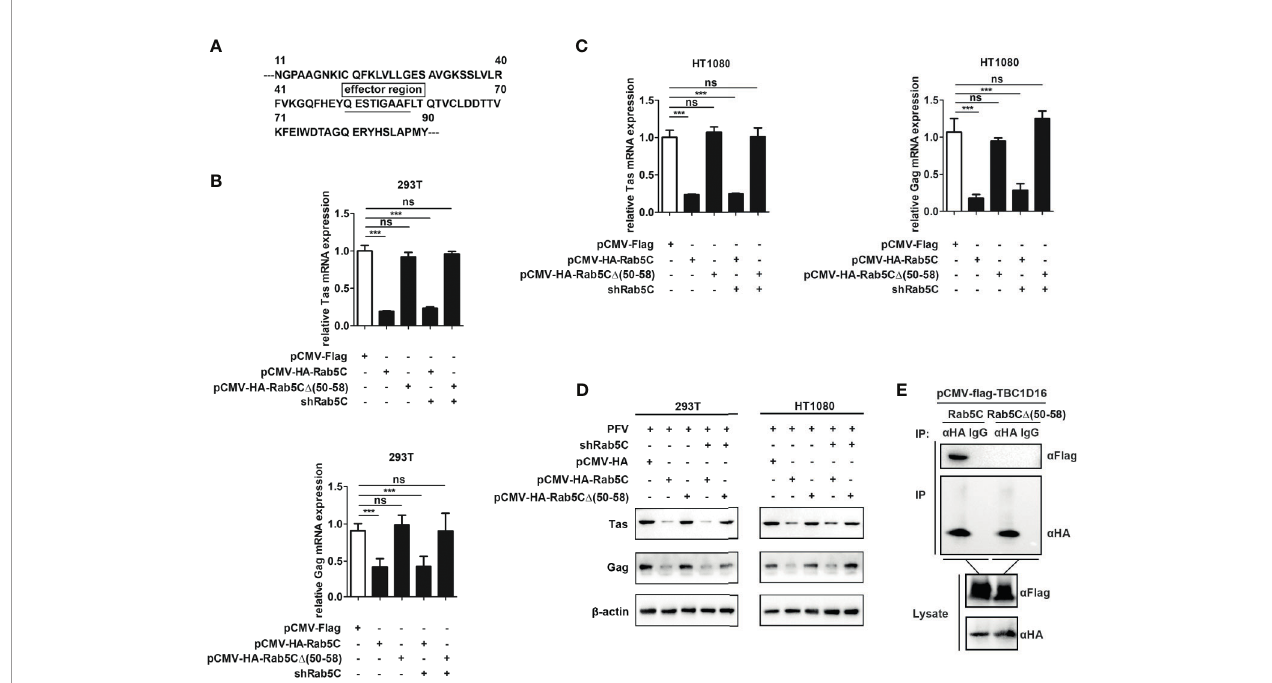
FIGURE 7 | QESTIGAAF (amino-acid residues 50-58) is important for Rab5C to inhibit PFV replication. (A) Schematic diagram of the effector region (amino-acid residues 50-58) of Rab5C. (B – D) QESTIGAAF (amino-acid residues 50-58) is important for Rab5C to inhibit PFV replication. (B, C) pCMV-HA-Rab5C or pCMV-HA- Rab5C D (50-58) (400 ng and pCMV-HA as an empty control) were transfected into HEK293T and HT1080 cells for 24 h. In another group, pCMV-HA-Rab5C or pCMV-HA-Rab5C D (50-58) were cotransfected with speci fi c shRNA of Rab5C into HEK293T and HT1080 cells for 24 h. After transfection, cells were infected with PFV (MOI = 0.5) for 48 h. The mRNA expression of Tas and Gag were detected by qPCR (*** p < 0.001 and ns , no signi fi cance). (D) pCMV-HA-Rab5C or pCMV-HA- Rab5C D (50-58) (400 ng and pCMV-HA as an empty control) were transfected into HEK293T and HT1080 cells for 24 h. In another group, pCMV-HA-Rab5C or pCMV-HA-Rab5C D (50-58) were cotransfected with speci fi c shRNA of Rab5C into HEK293T cells for 24 h. After transfection, cells were infected with PFV (MOI = 0.5) for 48 h. The protein expression of Tas and Gag was detected by Western blotting. (E) QESTIGAAF (amino-acid residues 50-58) is important for the interaction between Rab5C and TBC1D16. pCMV-Flag-TBC1D16 (3 m g) and pCMV-HA-Rab5C (3 m g) or pCMV-HA-Rab5C D (50-58) (3 m g) were cotransfected into HEK293T cells for 48 h, then Co-immunoprecipitation and immunoblot analysis were used to detect the interaction between TBC1D16 and Rab5C or Rab5C D